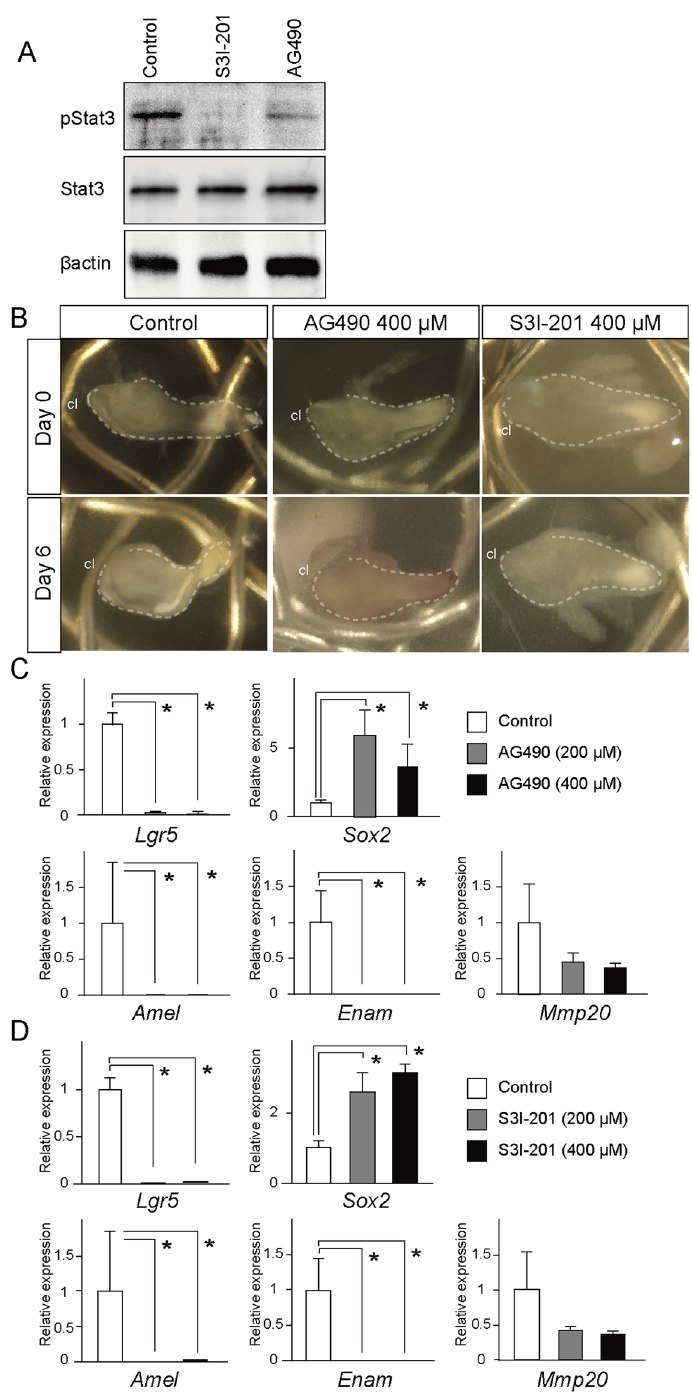
Figure 4. In vitro culture of the incisors and Stat3 inhibitor treatment. ( A ) A Western blot analysis showed that the application of Stat3 inhibitors of Ag490 or S3I-201 suppressed immunoreactivity to pStat3 but not to Stat3. ( B ) AG-490 or S3I-201, specific pharmaceutical Stat3 inhibitors, were applied on explanted lower incisors at E16.0 and cultured for 6 days. The size of the incisor explants did not change with Ag490 or S3I-201 treatment. ( C ) A qPCR analysis of the lower incisors showed that Ag490 treatment resulted in the marked downregulation of the Lgr5 expression, while the expression of Sox2 was upregulated. Ag490 treatment also resulted in the downregulation of the expression of Amelogenin , while AG490 significantly upregulated the Socs3 expression. * p < 0.05. ( D ) The Treatment of S3I-201 also specifically downregulated the expression levels of Lgr5 and Amelogenin , whereas the Sox2 expression did not deviate and the Socs3 expression was upregulated by S3I-201 treatment. * p < 0.05. cl, cervical